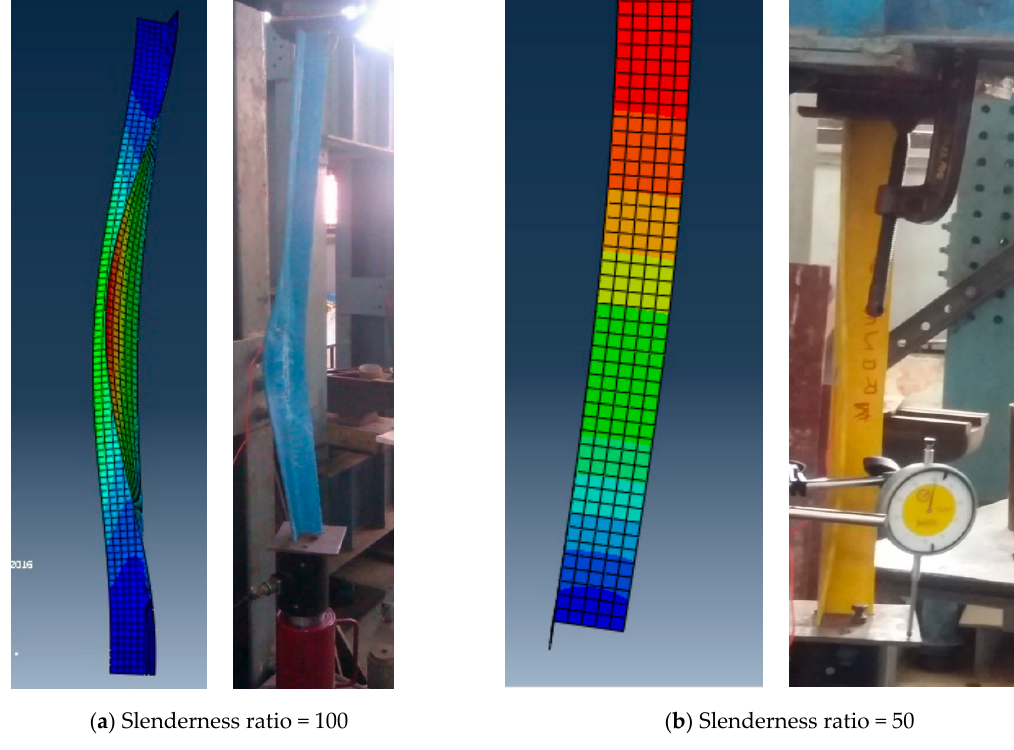
Figure 7. Buckling pattern—Experiment and Finite Element Analysis (FEA).